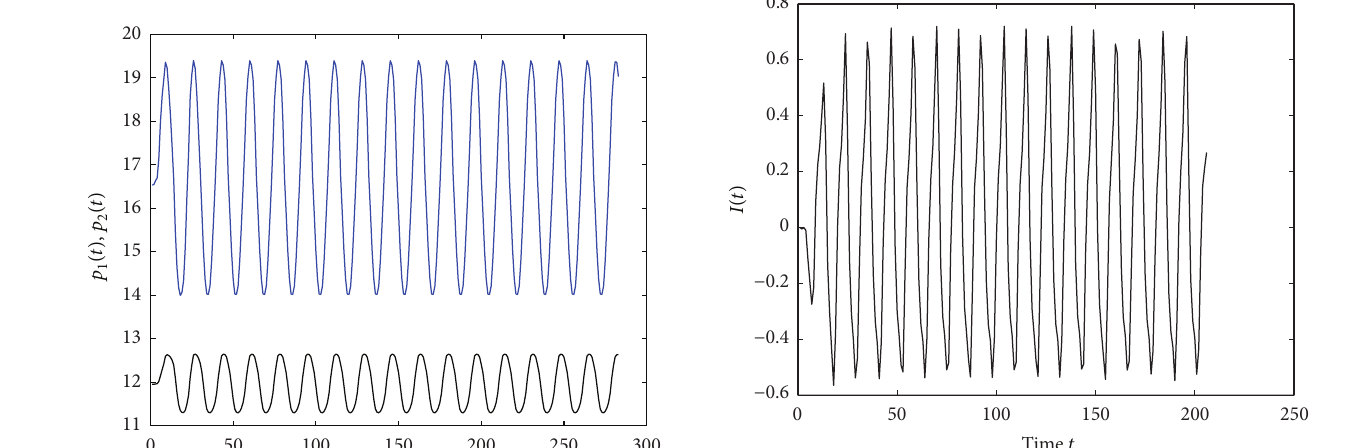
Figure 4: (𝑡,𝐼(𝑡)) , for 𝜏 = 𝜏 0 .